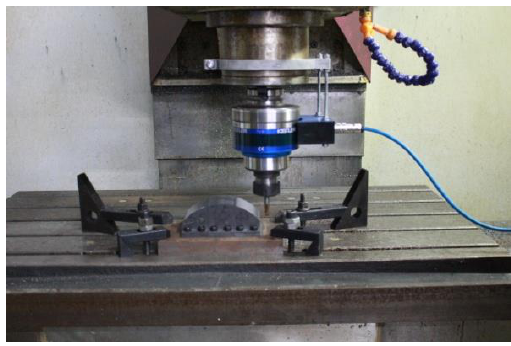
Figure 11. Kistler5236B rotary dynamometer.